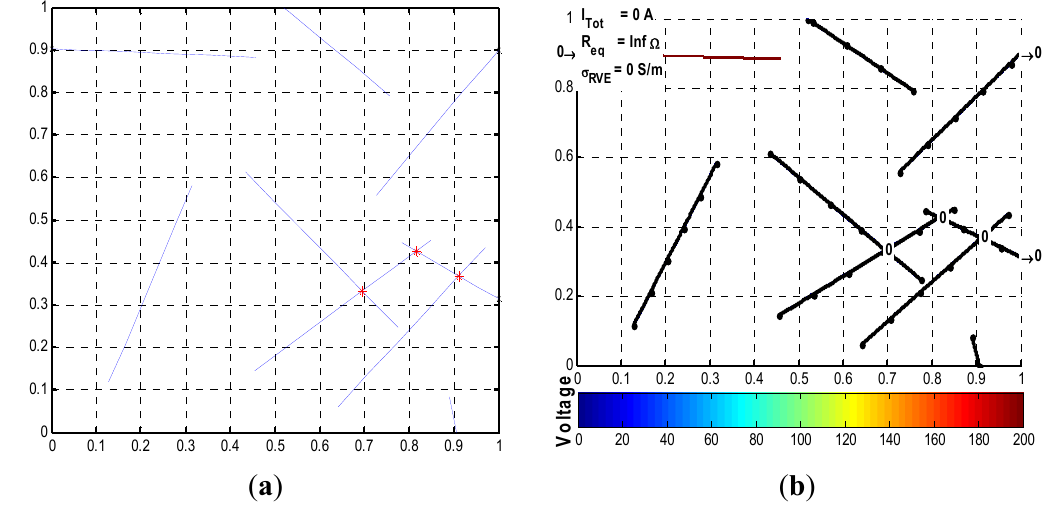
Figure 18. ( a ) Microstructure of straight nanotubes, c = 0.01, AR = 130; and ( b ) corresponding nodal voltage diagram.